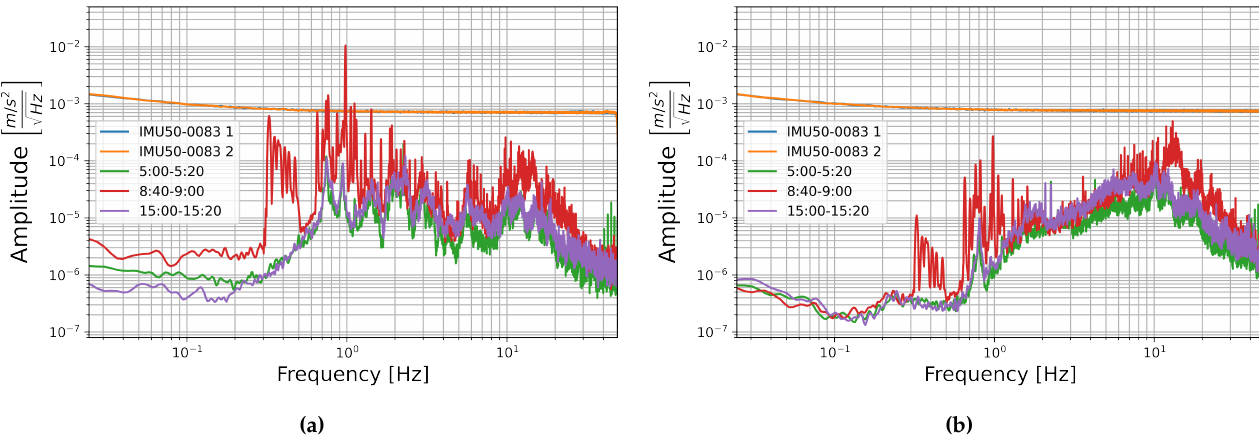
Figure 18. The square root of the PSD of self-noise recordings from sensor number 0083 (blue and orange) compared with building noise recorded in the North Tower of the Cologne Cathedral over three time spans: 5:00–5:20 (green), 8:40–9:00 (red), and 15:00–15:20 (purple) UTC time for ( a ) horizontal sensor component HNX with seismometer component HHE and ( b ) vertical sensor component HNZ with seismometer component